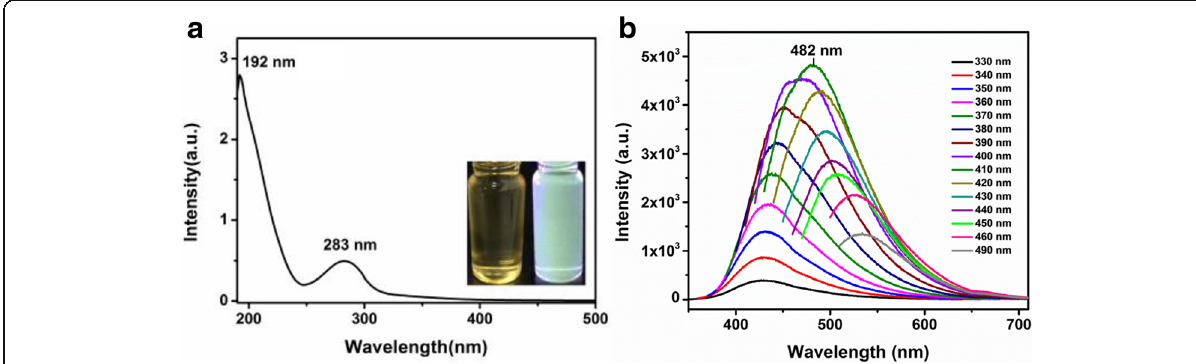
Fig. 4 a UV-Vis absorption spectra of CQDs, inset: optical images under daylight (left) and UV light (right). b PL spectra of CQDs at different excitation